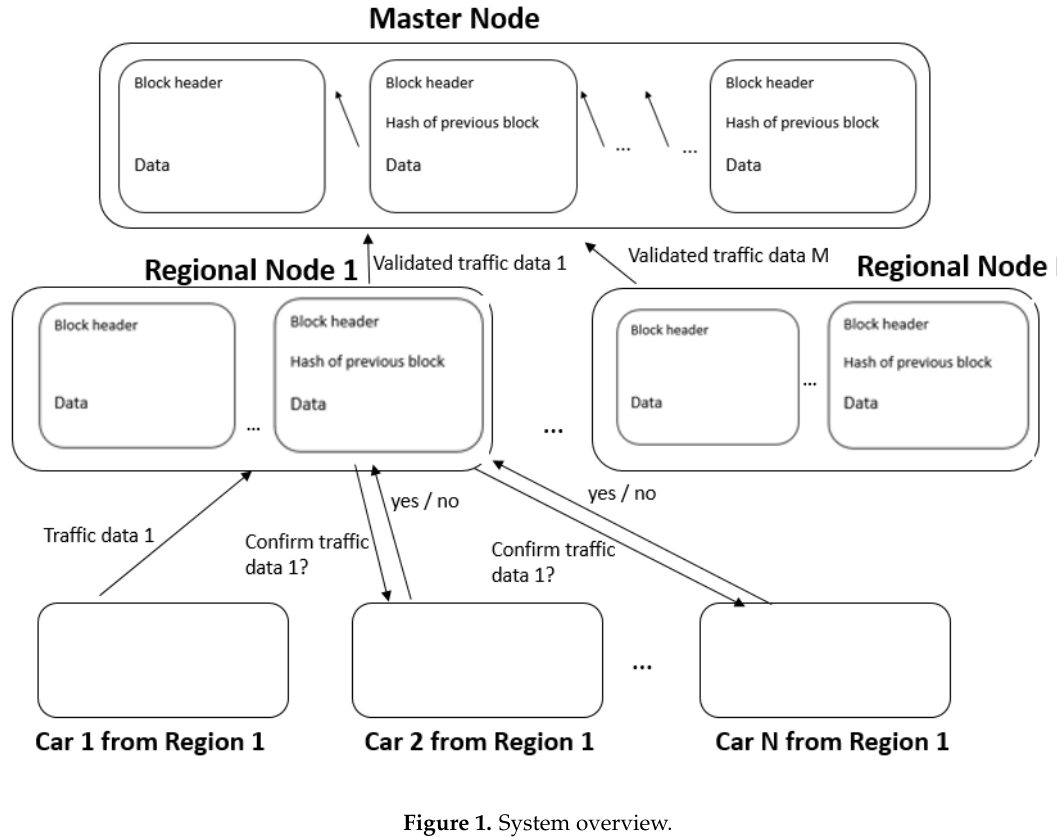
Figure 1. System